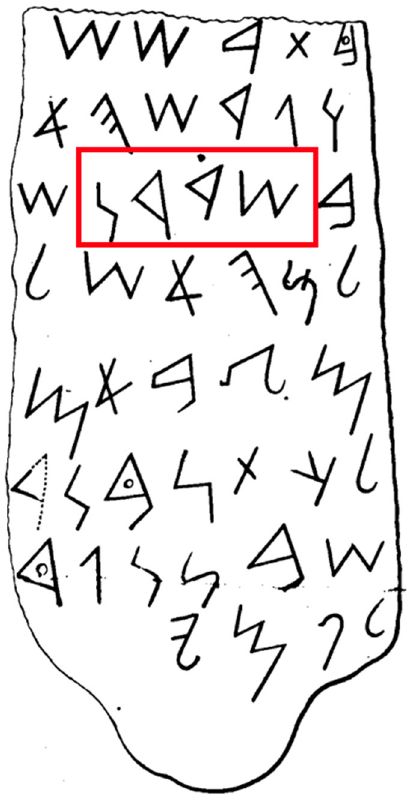
Figure 6. Nora Stone (‘Nora Stone in Gesenius’s 1837 Scripturae Linguaeque Phoeniciae Monumenta’) by Gesenius (1837).